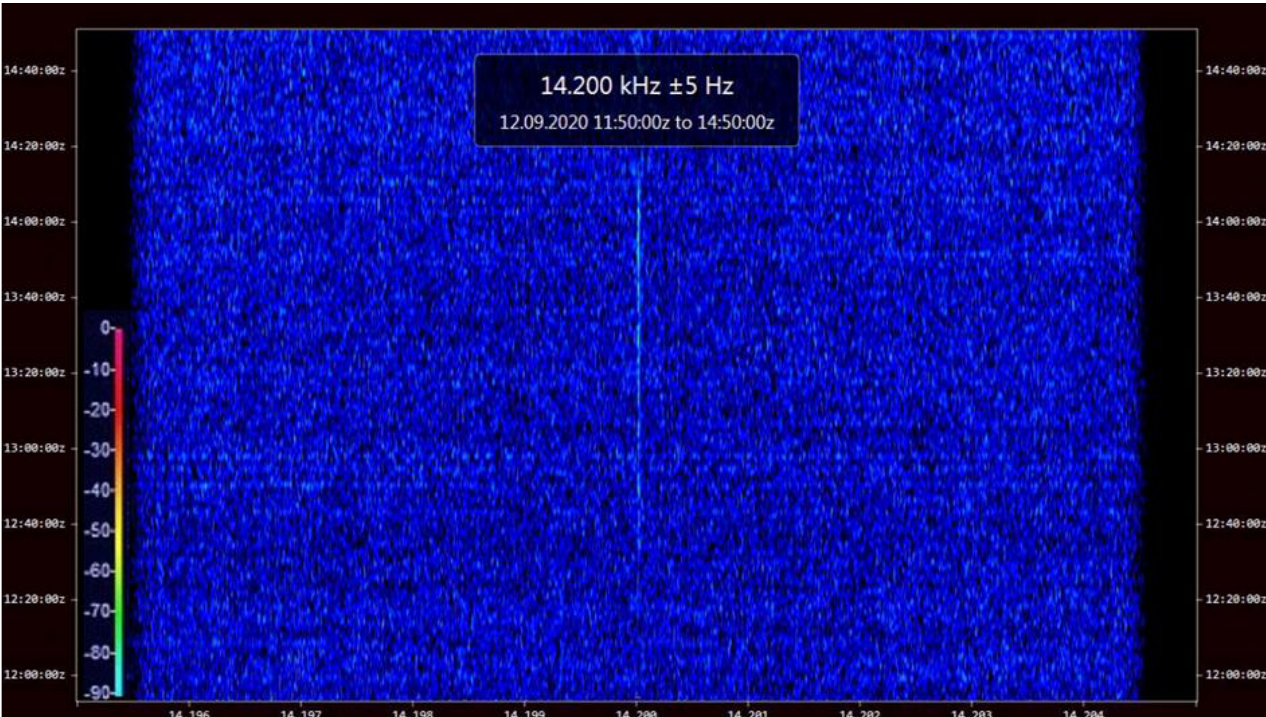
Figure 9. Signal power spectrum (dBm) of the stratospheric VLF light-balloon experiment produced in listening station near Salzburg, Austria (vertical axis: time UTC); courtesy of Christoph Ratzer.